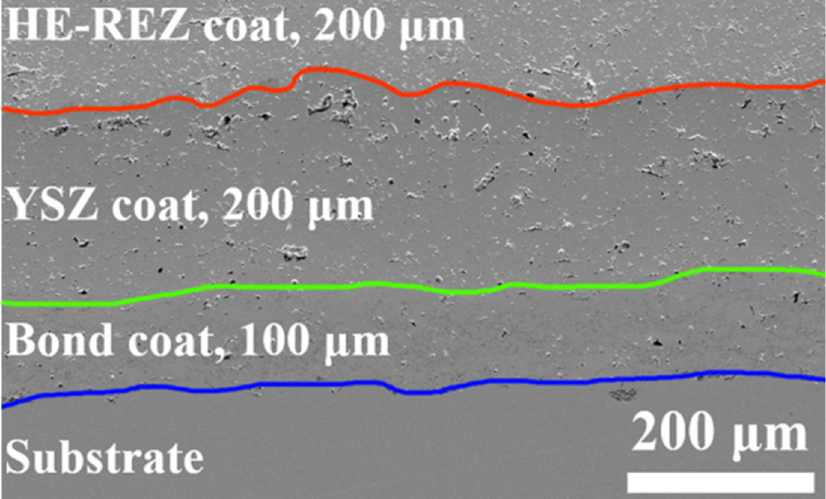
Figure 7. SEM image of the deposited double layer. Reprinted with permission from [35] Copyright